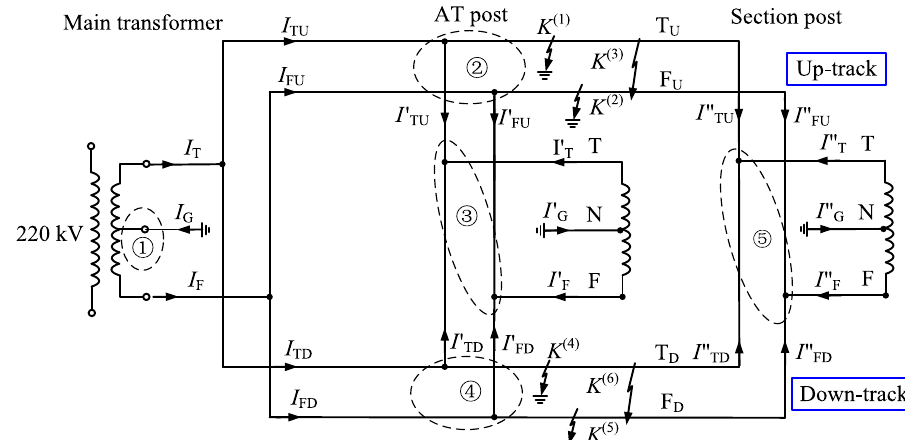
Fig. 1 Short-circuit tests in AT feeding